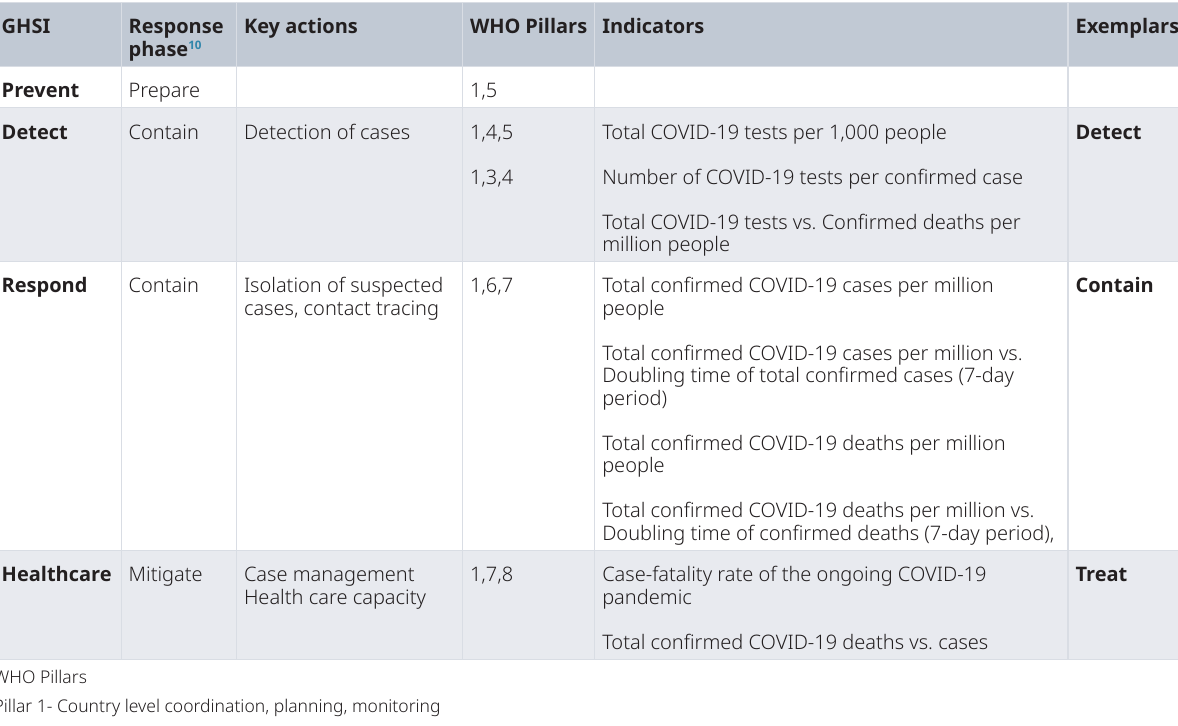
Table 1. Indicators for evaluating country performance cross referenced against the Global Health Security Index, WHO response pillars and the phases of response.